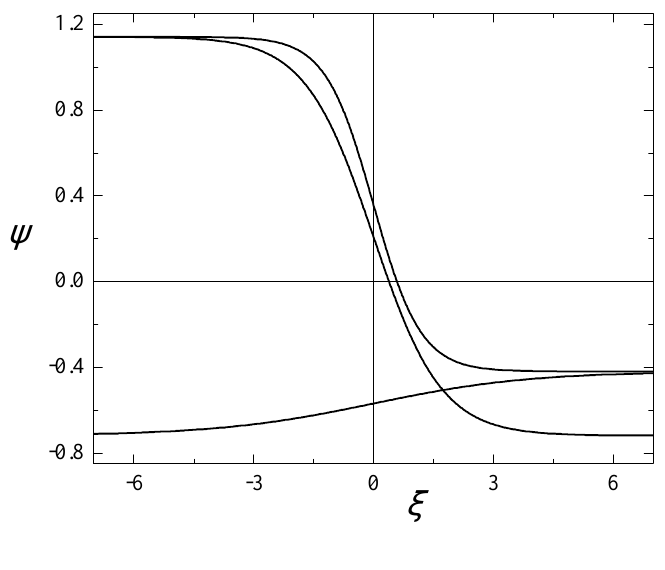
Fig. 2. The function )( xy for 1 = r and